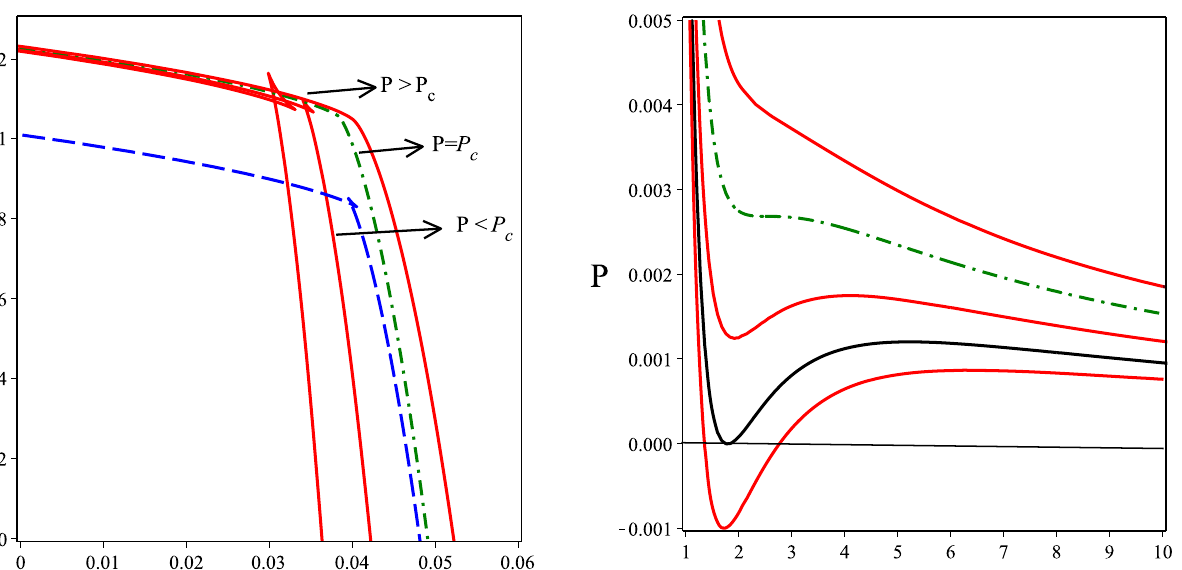
critical point is determined by ∂ P ∂ using Eq. (13), one can find P c r c which is independent of charge Q [31,32,40,67,72].